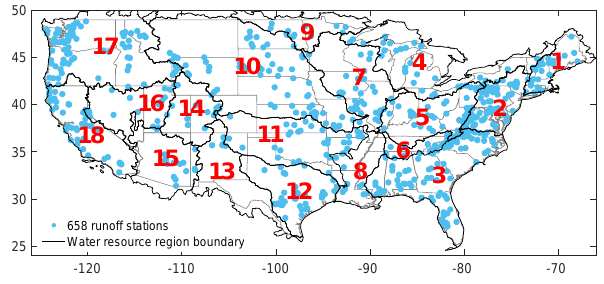
Figure 1. In all, 658 gaging stations (blue dots) and the 18 water resource regions defined by USGS over the